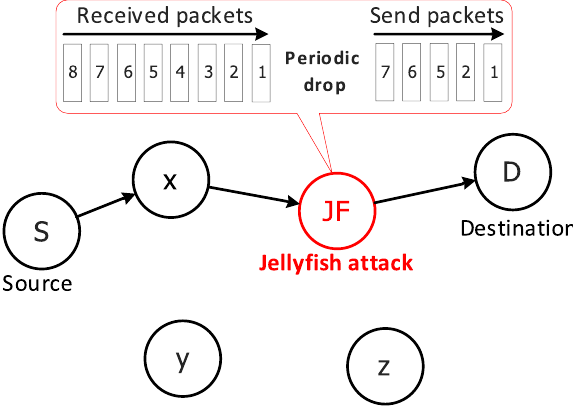
Figure 2. Jellyfish periodic drop attack.